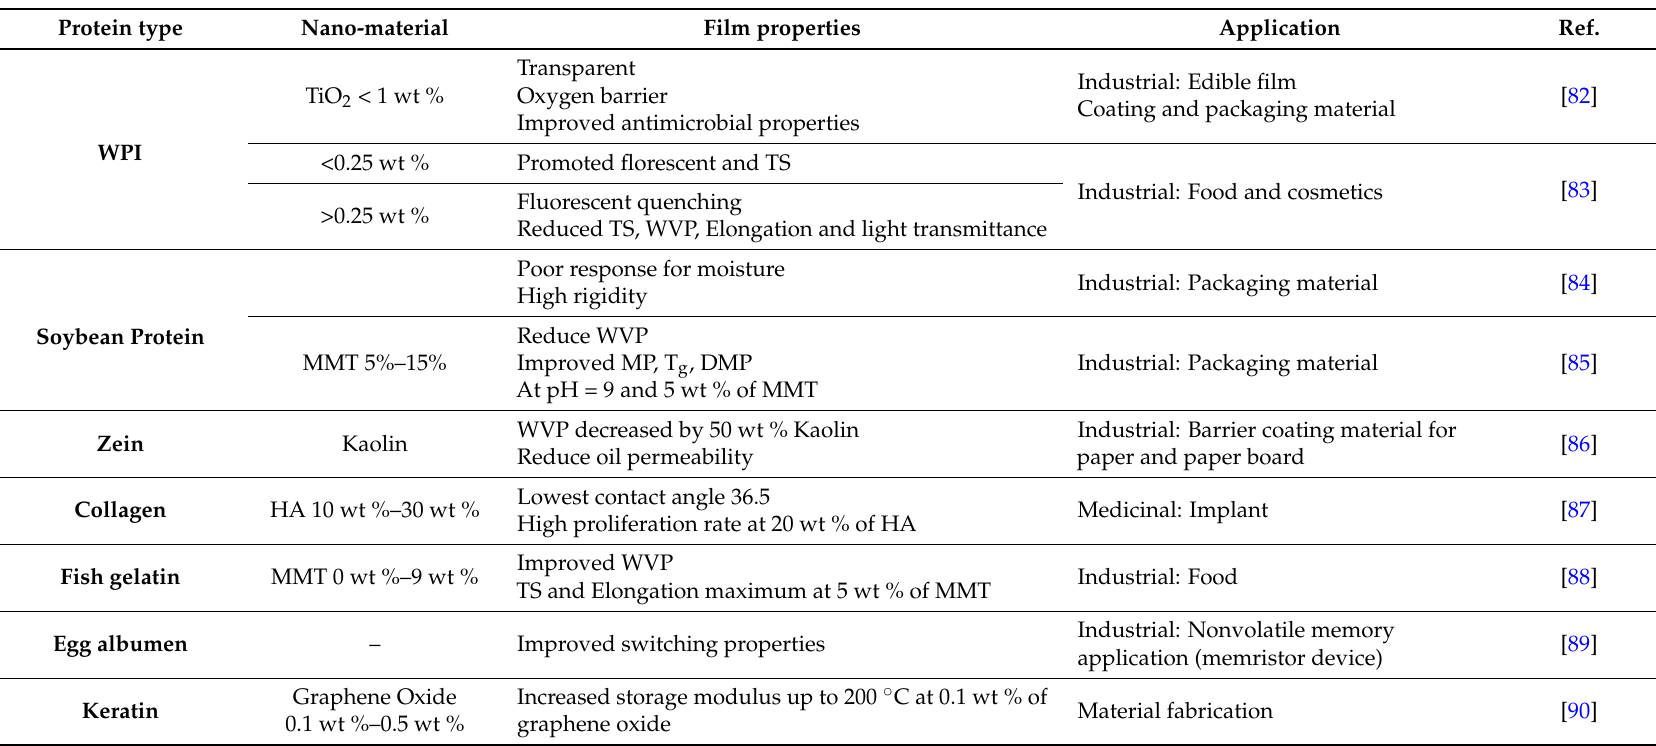
Table 3. Protein films’ incorporation of nanomaterials with their properties and